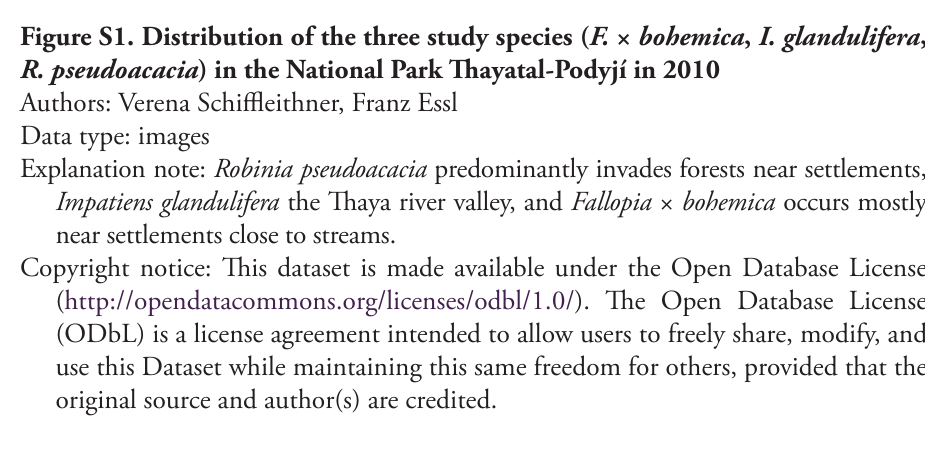
Figure S2. Distribution of the three study species, F. × bohemica , I. glandulifera , and R. pseudoacacia in the Austrian part of the National Park Thayatal-Podyjí